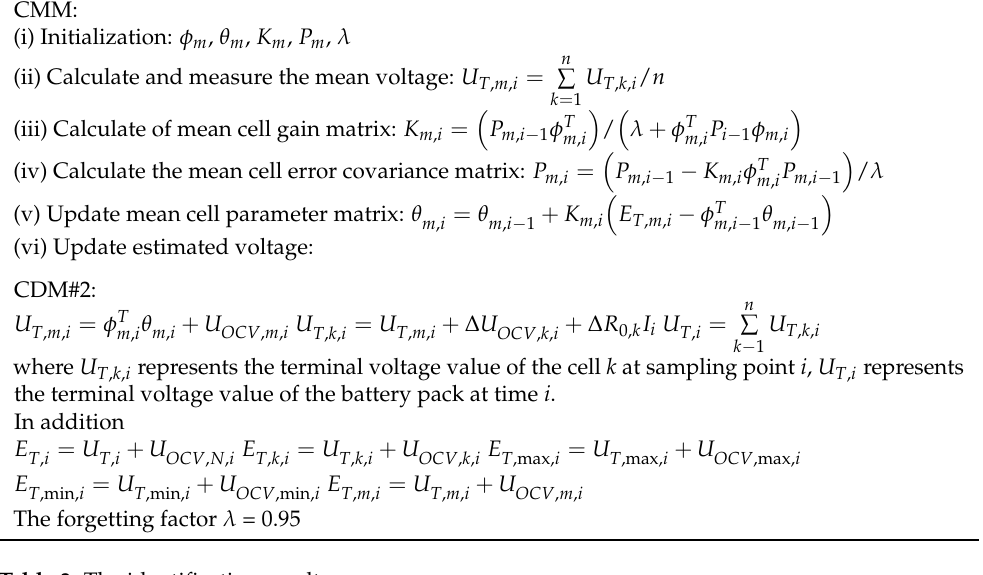
Table 3. The identification